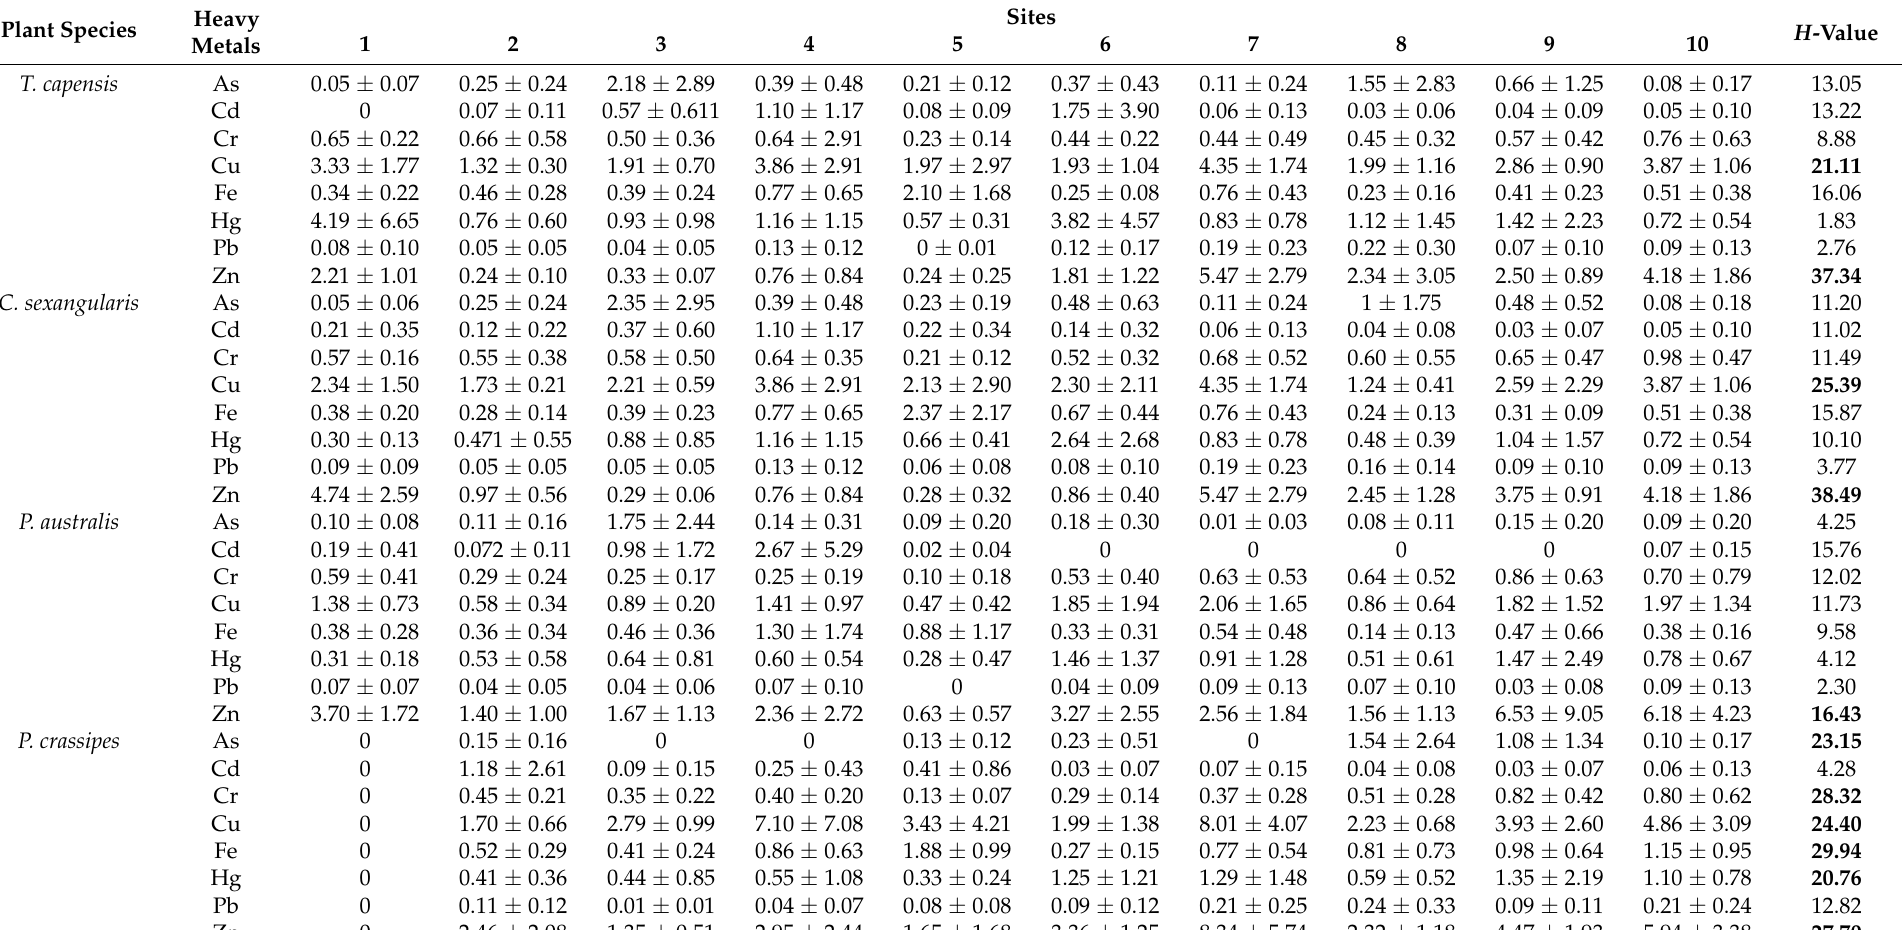
Table 2. The bio-concentration factor (BCF) mean values and ± standard deviation for measured heavy metals from native and non-native macrophytes along 10 study sites in Swartkops River from April–September 2018. Bolded H -values indicate significant differences (Kruskal–Wallis ANOVA, p < 0.05). NB, Pontederia crassipes and Stuckenia pectinata were not present at site 1 throughout the study, hence, BCF values = 0 for all heavy